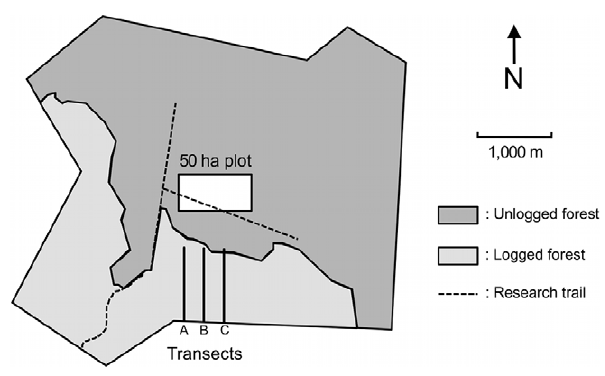
Figure 1. Map of Pasoh Forest Reserve, Peninsular Malaysia. The dark gray area represents unlogged forest and the light gray area represents forest that was lightly selectively logged in the 1950s. The rectangle at the center of the reserve is the CTFS 50 ha permanent plot. Broken lines represent research trails. Solid lines marked A to C are the transects along which our observations were conducted.